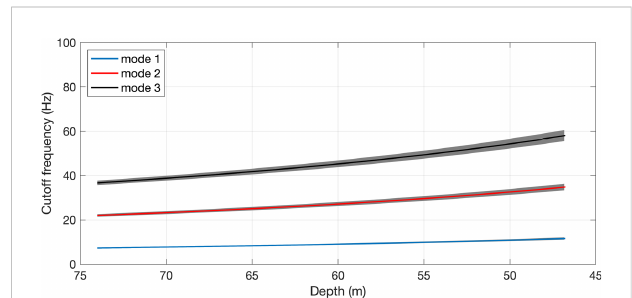
FIGURE 7 Cutoff frequency as a function of depth in layer-2 inverted on the x- axis. Blue, red, and black lines show the cutoff frequencies of modes 1, 2, and 3, respectively. The shaded gray area represents the vertical errors caused by the depth variation by ± 2 m.